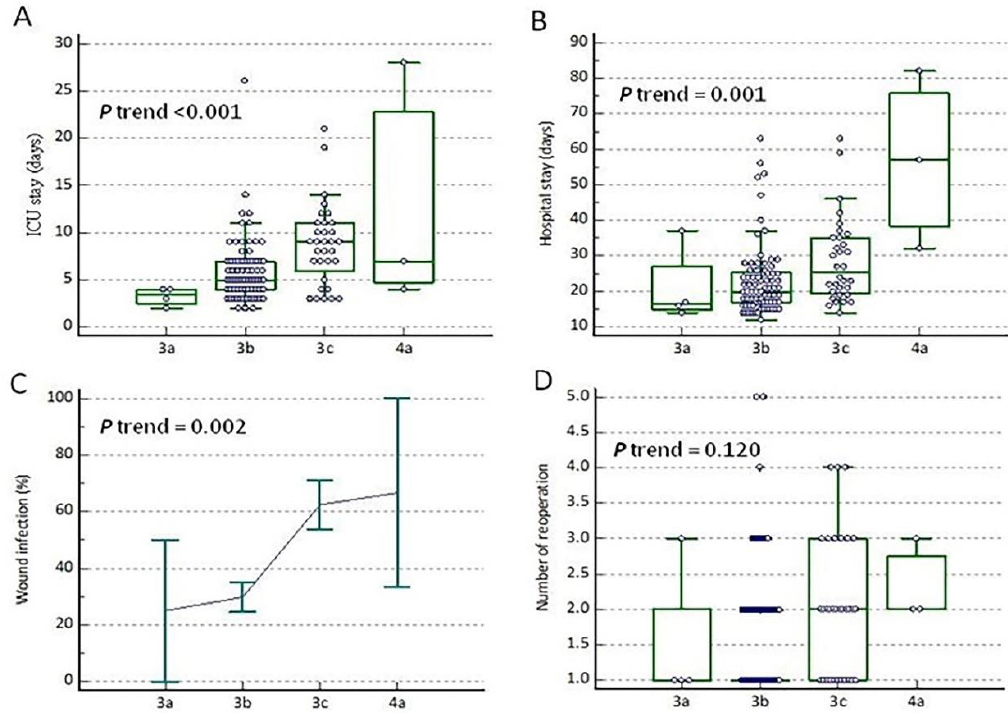
Figure 2. The Box-Whisker plot of factors associated with the severity level from grade IIIa to grade IVa, including the duration of intensive care unit stay ( A ), duration of hospital stay ( B ), percentage of wound infection ( C ), and the number of reoperations during the current hospitalization ( D ). All four factors exhibited a rising trend from grade IIIb to grade IIIc, which represented an increasing severity level of post-operative complications. The error bar represents the standard error.